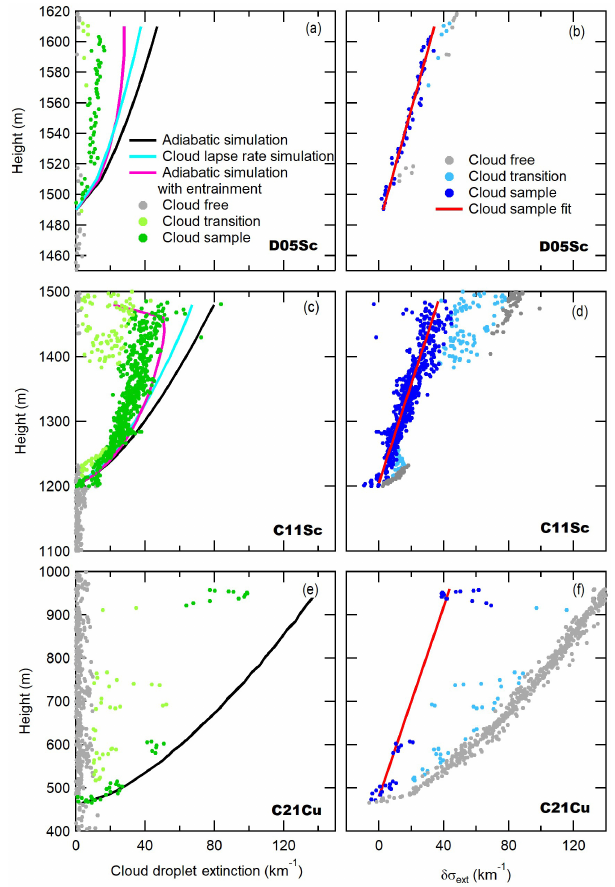
Figure 8. Vertical profiles of measured and simulated cloud ex- tinction from flights D05Sc, C11Sc and C21Cu ( a , c and e , re- spectively; Table 2). In situ measurements are classified into cloud, cloud-transition and cloud-free observations. The differences be- tween UAV-observed and ACPM-simulated cloud extinction (black line) in left figures (a, c, e) are used to calculate ( δσ ext ) as a func- tion of altitude in the right figures (b, d, f) . The slope of the best fit through in-cloud measurements (red line) represents the increase in δσ ext as a function of cloud thickness.